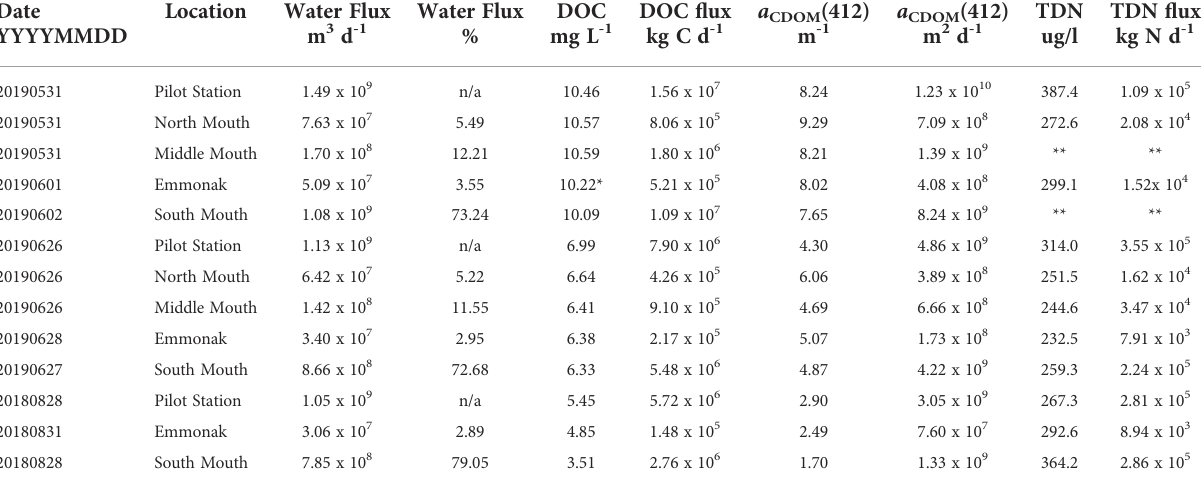
TABLE 4 Flux of biogeochemical variables DOC (kg C d -1 ) and TDN (kg N d -1 ) and CDOM absorption a CDOM (412)(m 2 d -1 ) at Pilot